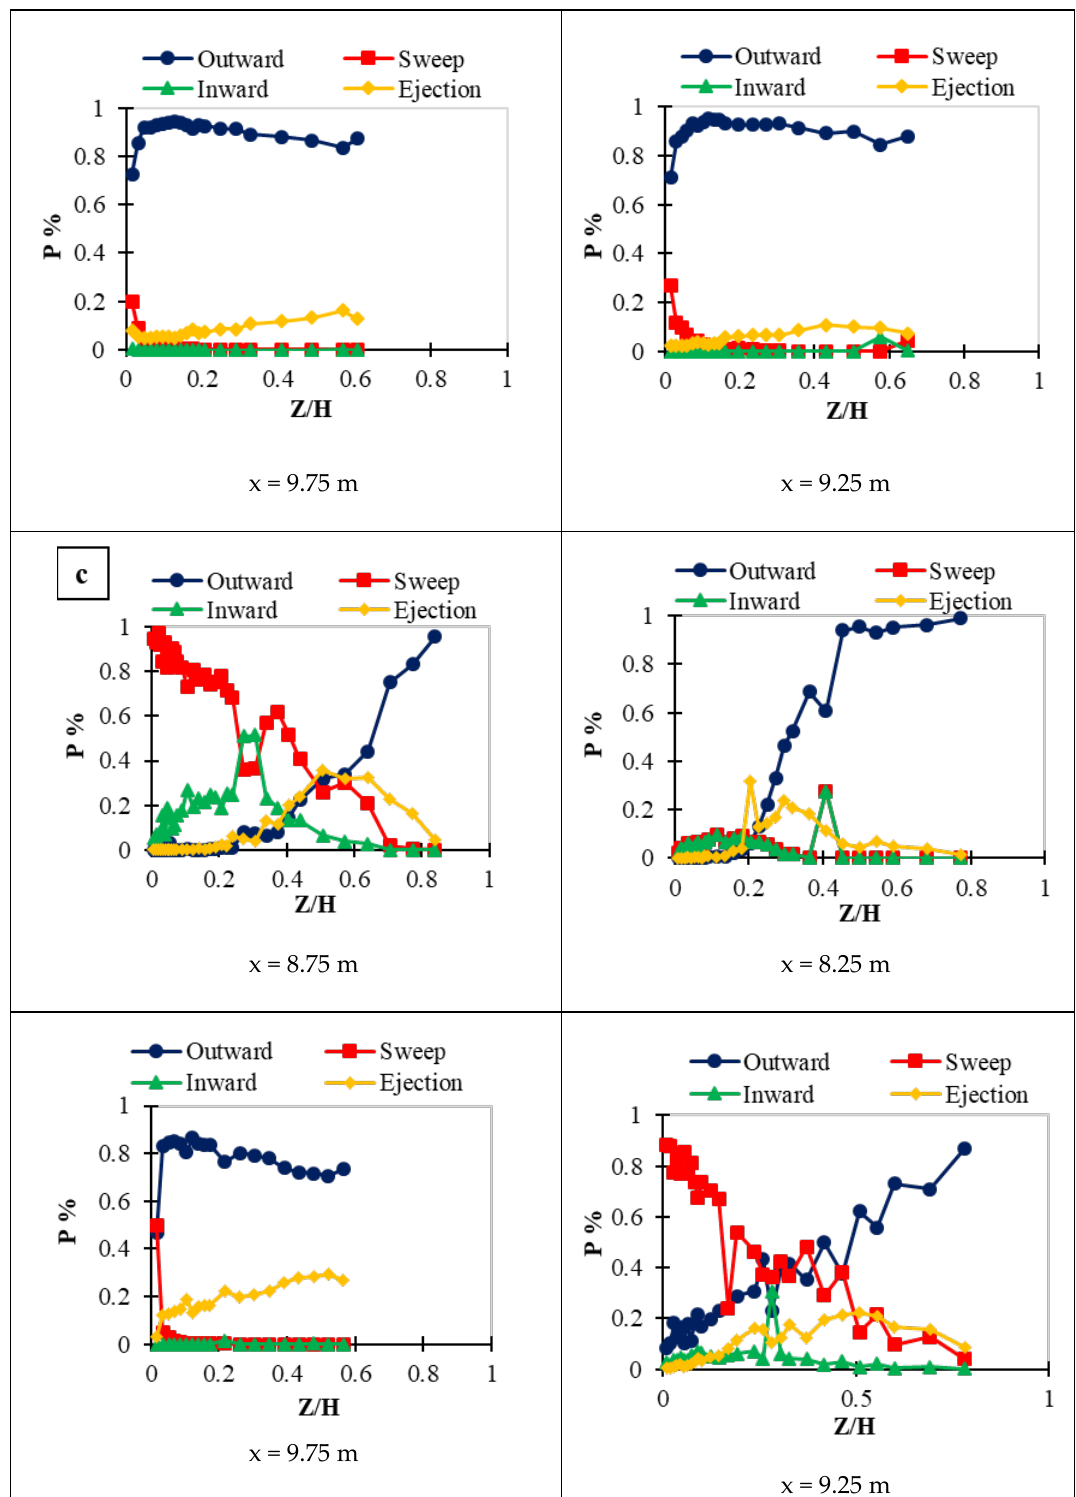
Figure 13. Dominant interactions using quadrant analysis for: ( a ) series “ a ” test on the central axis of the channel, with an angle of 5° and aspect ratio of less than five, ( b ) series “ b ” test on the central axis of the flume, with an angle of 5° and aspect ratio of more than five, and ( c ) series “ c ” test on the central axis of the flume with an angle of 20° and aspect ratio of less than five.